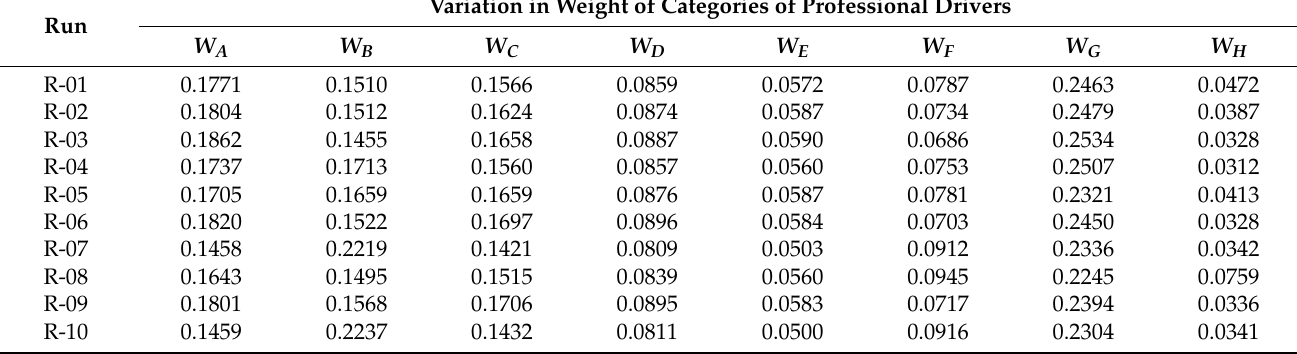
Table 14. Variation in weight of categories of professional